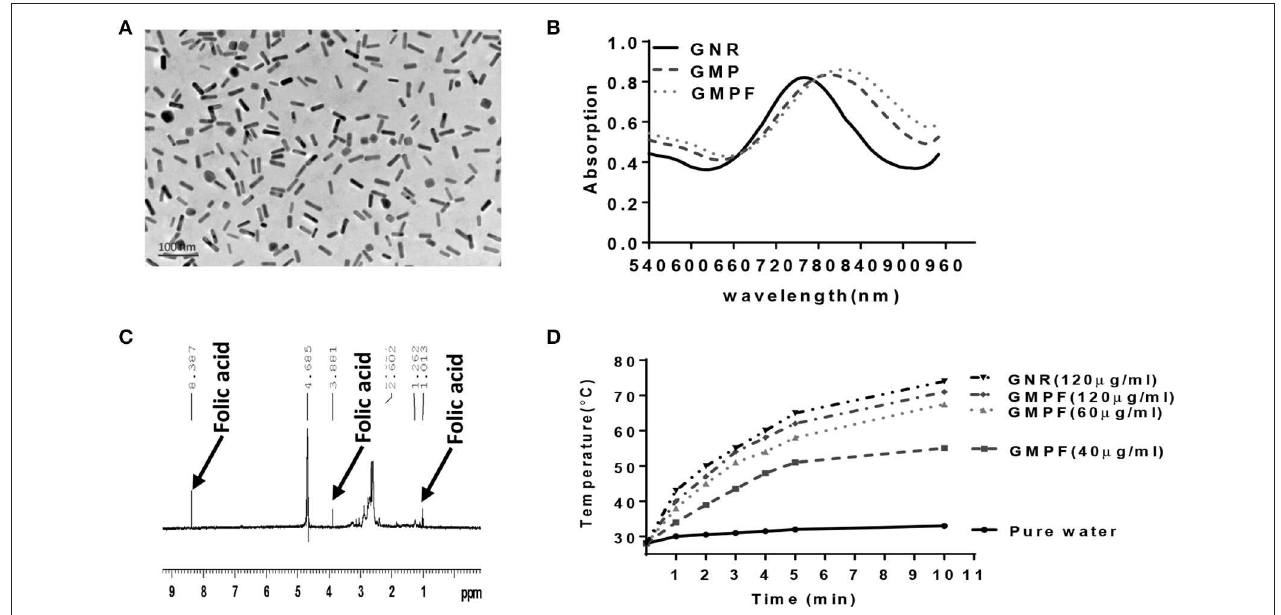
FIGURE 1 | Characterization of photo-thermal effects of a multi-functionalized gold nanorod GNR-MUA-PEI-FA, GMPF. (A) Transmission Electron Microscopy (TEM) image of modified GNRs, GMPF. (B) UV-Vis absorption spectra of GNR modified by CTAB (GNR), or MUA-PEI (GMP), or MUA-PEI-FA (GMPF). (C) The chemical signature of folic acid on the surface of GNR determined by NMR after GNR conjugation with folic acid. (D) Temperature increase induced by photothermal effects of GNR or GMPF in vitro . 2mL of GNR (120 µ g/mL) or GMPF (40, 60, 120 µ g/mL), or deionized water was irradiated at 2 W/cm 2 with the laser wavelength at 808nm for 10min. The temperatures were measured and plotted at indicated time